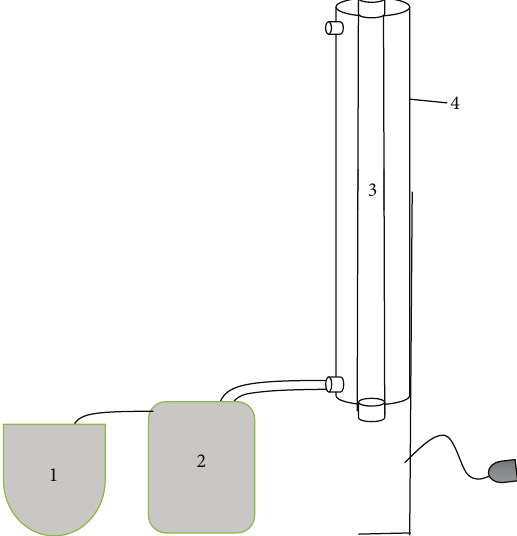
Figure 3: General schematic of the UV/H 2 O 2 AOP photochemical reactor (1: reservoir, 2: peristaltic pump, 3: UV lamp, and 4: